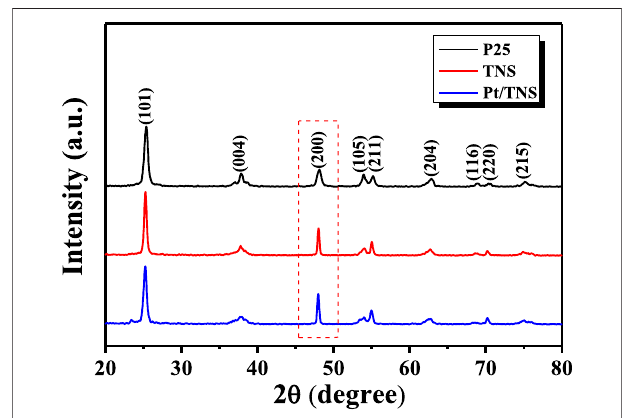
FIGURE 2 | XRD patterns of anatase P25, TNS, and Pt/TNS.